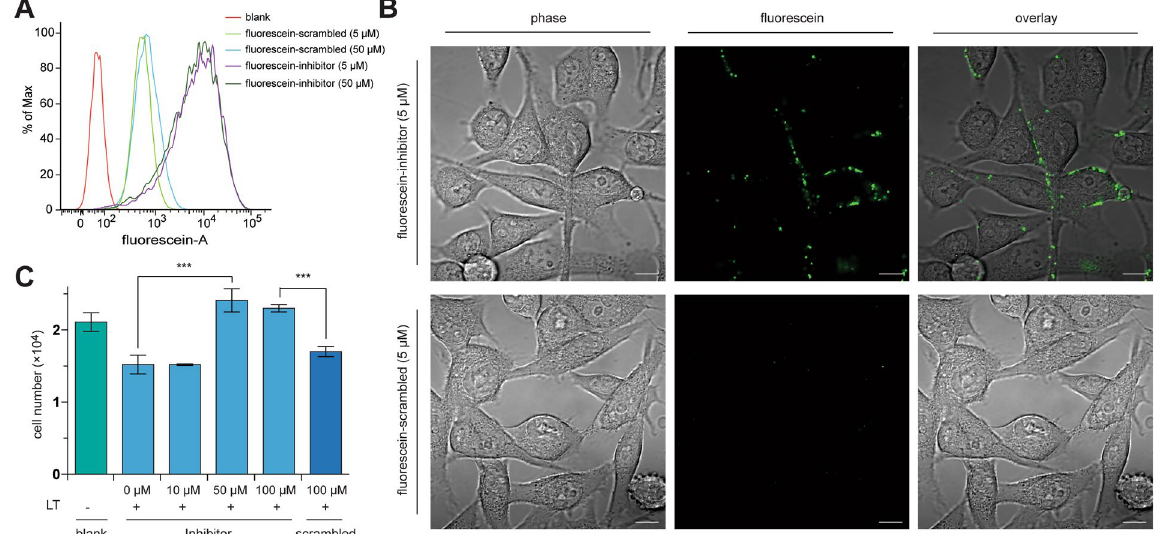
Figure 4. Cell-based analysis of CLR(4-Cl-F)T(inhibitor) and (4-Cl-F)CRTL(scrambled) activity. ( A ) Fluorescence-activated cell sorting shows that fluorescein-tagged CLR(4-Cl-F)T (at 5 or 50 µ M) binds to BHK-21 cells, whereas the fluorescence from BHK-21 cells incubated with the fluorescein-tagged scrambled control, at 5 or 50 µ M is weaker. ( B ) Confocal microscopy with the fluorescein-tagged CLR(4-Cl-F)T (5 µ M) shows binding of the inhibitor to surface of BHK-21 cells, while binding by fluorescein-tagged scrambled control at 5 µ M is not observed. Scale bar is 10 µ m. ( C ) Toxin neutralization assay; CLR(4-Cl-F)T at 50 µ M and above protects J774 cells from 0.1 mg/mL of lethal toxin, with a similar number of cells present as the no toxin control. No protective effect was observed from 100 µ M (4-Cl-F)CRTL (scrambled control). *** p < 0.00; data represented as mean ±